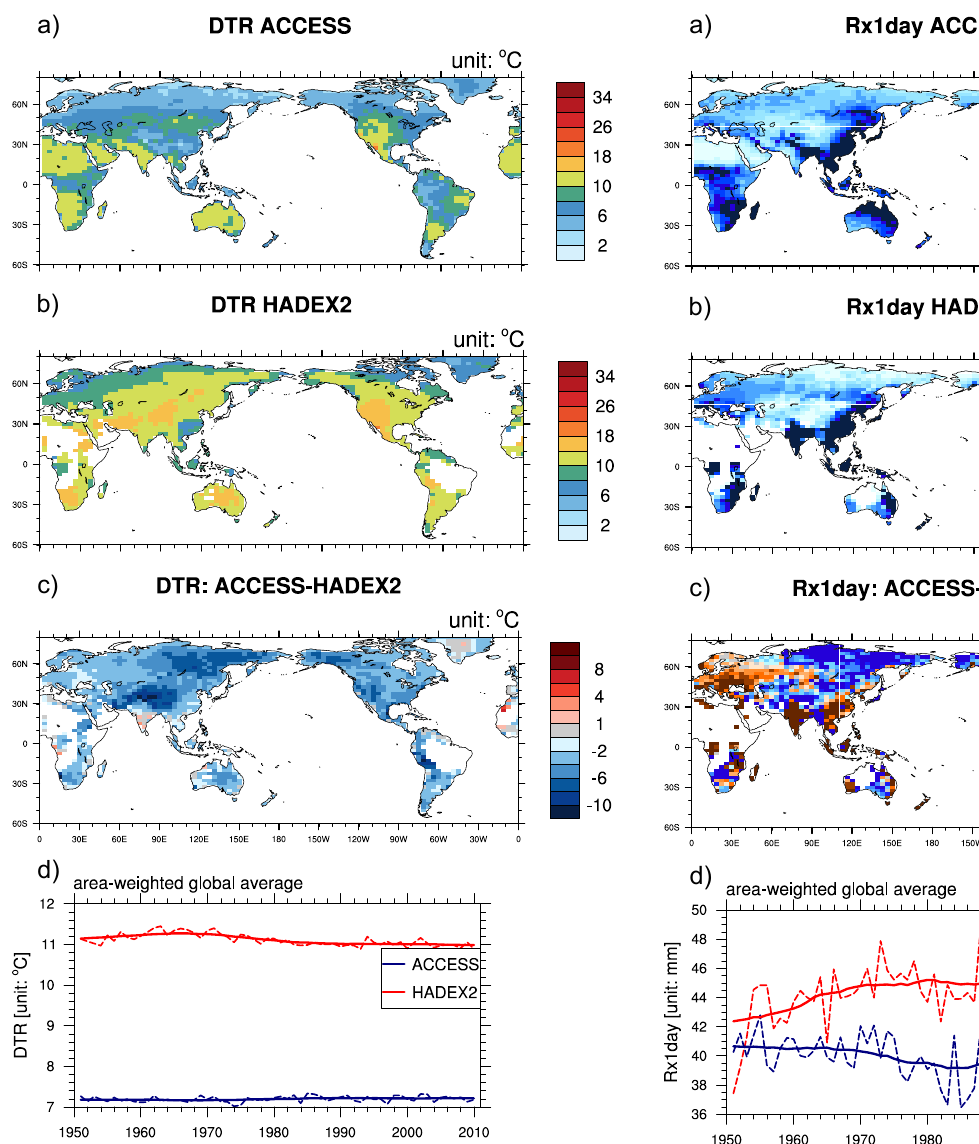
Fig. 6. Annual diurnal temperature range (DTR) for ACCESS1.3b (a) , HadEX2 (b) , bias (c) and the global average time series show- ing trends (d) . Unshaded areas reflect missing observation data. We applied a static masked only including grid points where more than 50 years of data (out of 60) were available to calculate the global average. The solid lines in (g) show the time series smoothed by a 21-year Gaussian filer, while the dashed lines show the yearly val- ues.